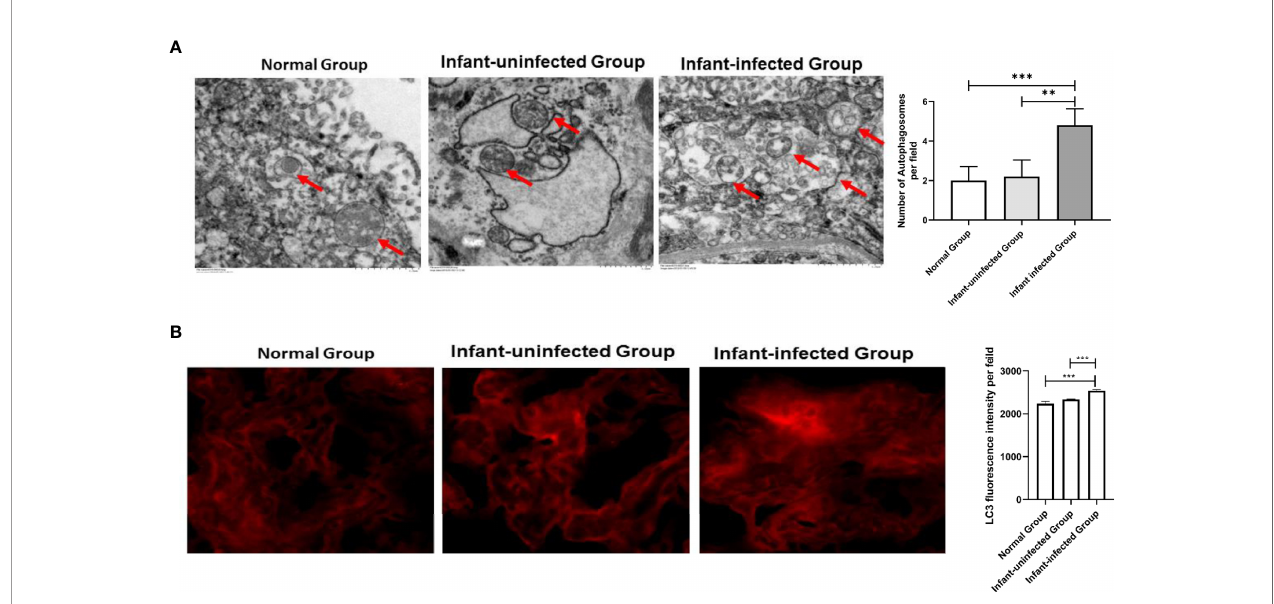
FIGURE 4 | Expression differences in autophagy markers between the mother-infant immunoprophylaxis failure group and mother-infant immunoprophylaxis group (***p<0.001, **p<0.01). (A) The number of autophagosomes was detected by electron microscopy, the autophagosomes were indicated by red arrows and quanti fi ed by randomly selecting and screening 100 fi elds for two samples in the infants-uninfected group and two samples in the infants-infected group. (B) The protein levels of LC3 were measured with immuno fl uorescent assays in placental tissue of normal group, infant-uninfected group, and infant-infected group (200×). The quantitative analysis of LC3 fl uorescence intensity per fi eld was examined by Image J.